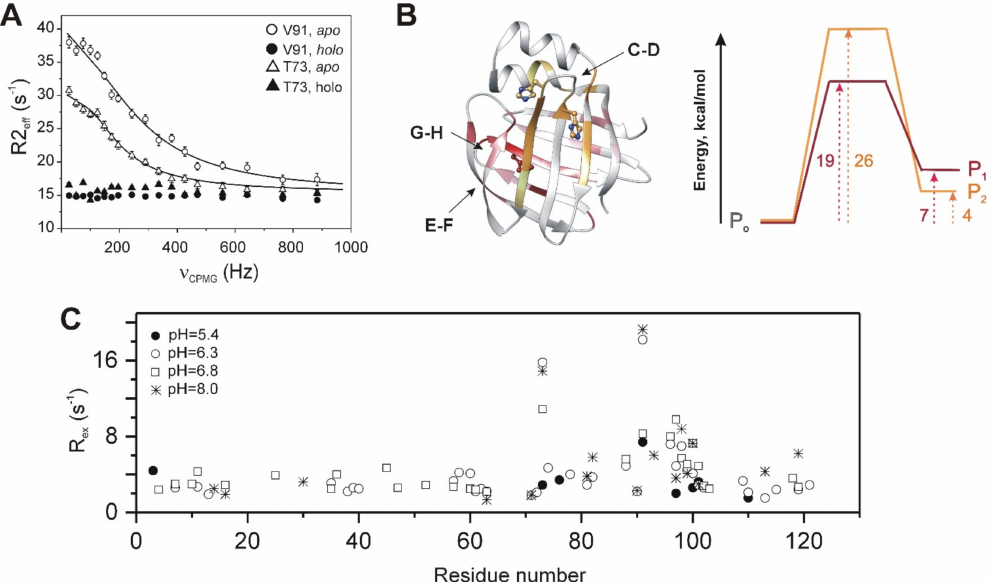
Figure 6. Slow dynamics in human ileal BABP mediating ligand entry as determined by 15 N NMR relaxation dispersion measurements. ( A ) Contribution from conformational exchange (R ex ) to trans- verse relaxation of backbone 15 N nuclei of T73 (triangles) and V91 (circles) in apo hI-BABP (empty symbols) and the heterotypic hI-BABP:GCA:GCDA complex (filled symbols) as a function of the CPMG field strength. Ceasing of µ s-ms-timescale motions upon bile salt binding is indicated by the flat R ex profile in the holo form. Solid lines represent best-fit curves corresponding to a global fit of 24 residues assuming a two-state exchange process with an exchange rate constant, k ex = 836 ± 59 s − 1 and population of the higher energy state, p e = 3.1 ± 0.2% (10 ◦ C). ( B ) Left: Residues sensing a conformational exchange in the temperature range of 10–18 ◦ C in apo hI-BABP can be grouped into two clusters with slightly different exchange rates. Chemical shift differences between the ground and the scarcely populated higher energy state deduced from NMR relaxation measurements are mapped on the ribbon diagram (PDB: 1o1u [39]) in pink-to-red and yellow-to-orange gradient for the faster and the slower cluster, respectively. The three histidines (H52, H57, H98) are highlighted in a ball-and-stick representation. Profiles showing the energy barrier and the free energy difference between the ground and the higher energy state for the faster (P o ↔ P 1 , red) and the slower (P o ↔ P 2 , orange) conformational fluctuation in apo hI-BABP deduced from temperature-dependent CPMG relaxation dispersion measurements are shown on the right. ( C ) Contribution from conformational exchange to transverse relaxation in apo hI-BABP at different values of pH. Note the considerably smaller number of residues (filled symbols), sensing a conformational fluctuation below the pK a (6.4–6.6 as determined by NMR) of